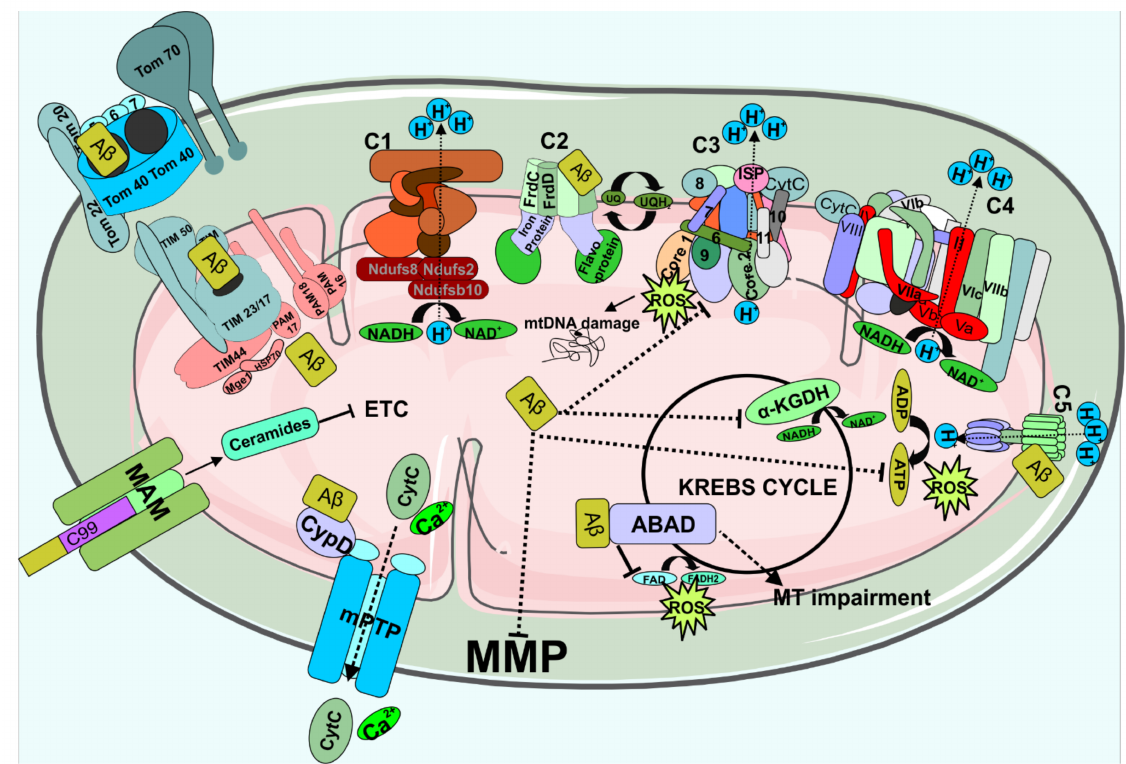
Figure 3. Mechanism of A β induced mitochondrial dysfunction: A β enters the mitochondria (MT) through the TOM40 and TIM 23 complex. A β interacts with the A β -binding alcohol dehydrogenase (ABAD), Cyclophilin D and electron transport complexes (ETC) (C2, C3 and C5) which enhance the ROS production, Cytochrome C liberation, ROS mediated MT-DNA damage, MT impairment and mPTP opening where CytC exported to the cytoplasm. In addition, MAM bound APP fragment (C99) activates ceramides that inhibits the